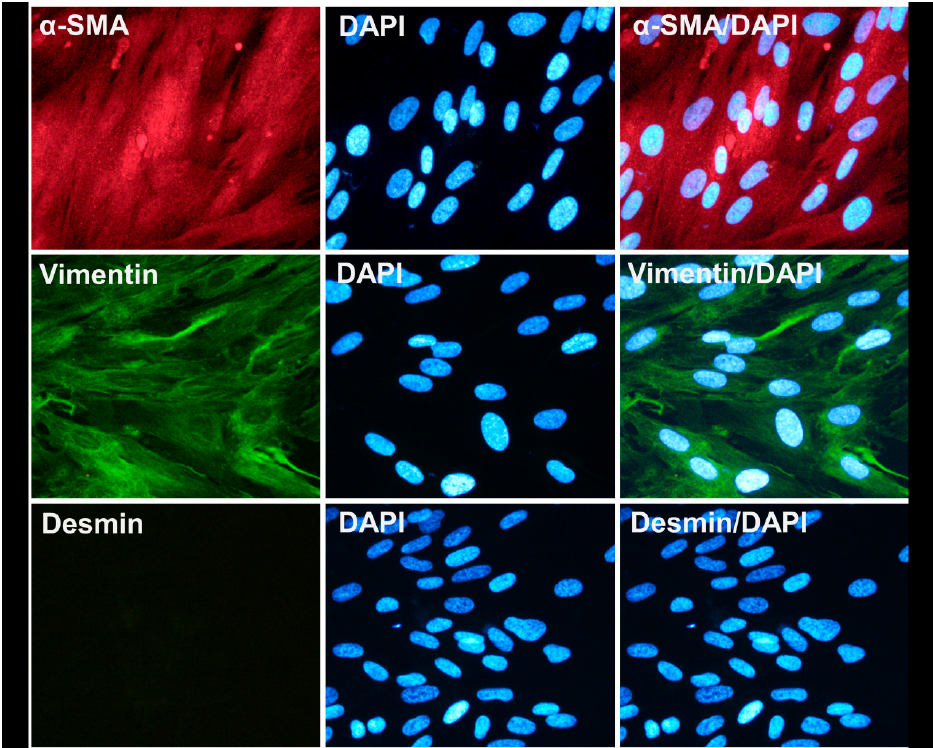
Figure 1. Characterization of isolated colonic subepithelial myofibroblasts. Representative images of colonic subepithelial myofibroblasts that were found positive for α -SMA (red) and vimentin (green) expression and negative for desmin expression. Nuclei were stained with DAPI (blue). Magnification was set at 400 ×